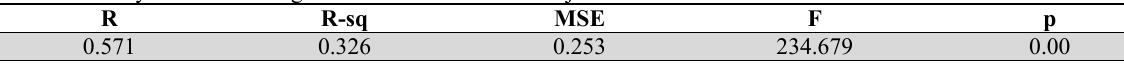
Model summary for effect of organizational commitment on job satisfaction R